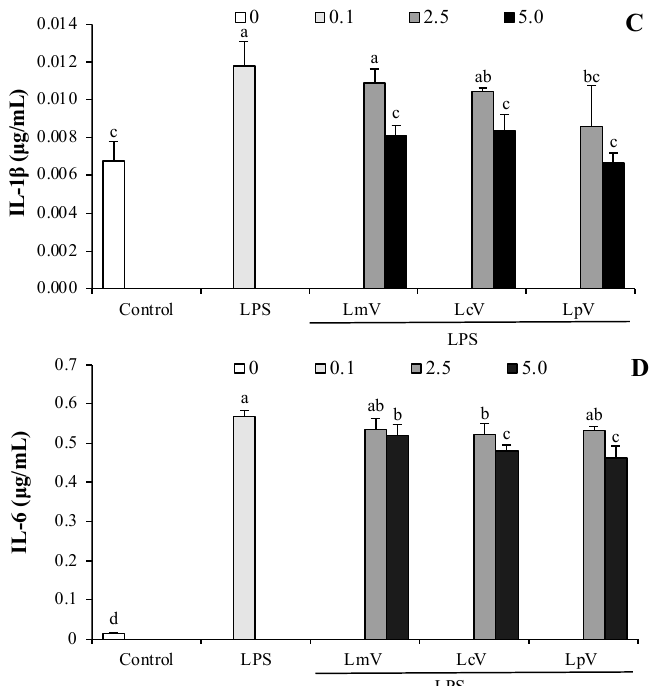
Figure 6. Effect of Le. Mesenteroides, Ll. curvatus, or Lp. plantarum -derived ECVs (LmV, LcV, or LpV)) on ( A ) the production of NO, ( B ) TNF- α , ( C ) IL-1 β , and ( D ) IL-6 in LPS-stimulated microglial cells. Microglial cells were treated with LmV, LcV or LpV for 2 h prior to the addition of LPS (0.5 μ g/mL), and the cells were further incubated for 24 h. Values are expressed as the mean ± SD ( n = 4) and those followed by different letters (a–f) within a property are significantly different ( p < 0.05) according to Duncan’s multiple range test.